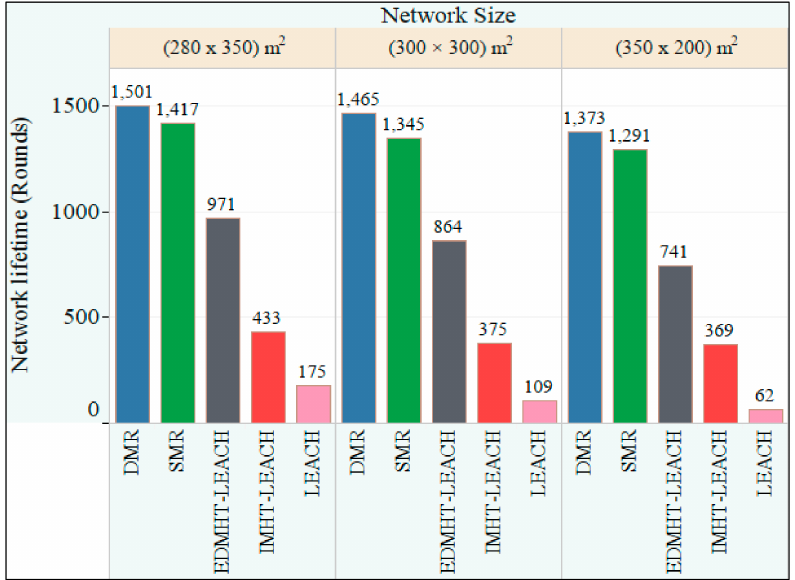
Figure 9. The comparison of the network lifetime versus the network size in the Dynamic Multi-Hop Routing (DMR), Static Multi-Hop Routing (SMR), Enhancing DMHT-LEACH (EDMHT-LEACH), Improved MHT-LEACH (IMHT-LEACH) and conventional LEACH approaches.